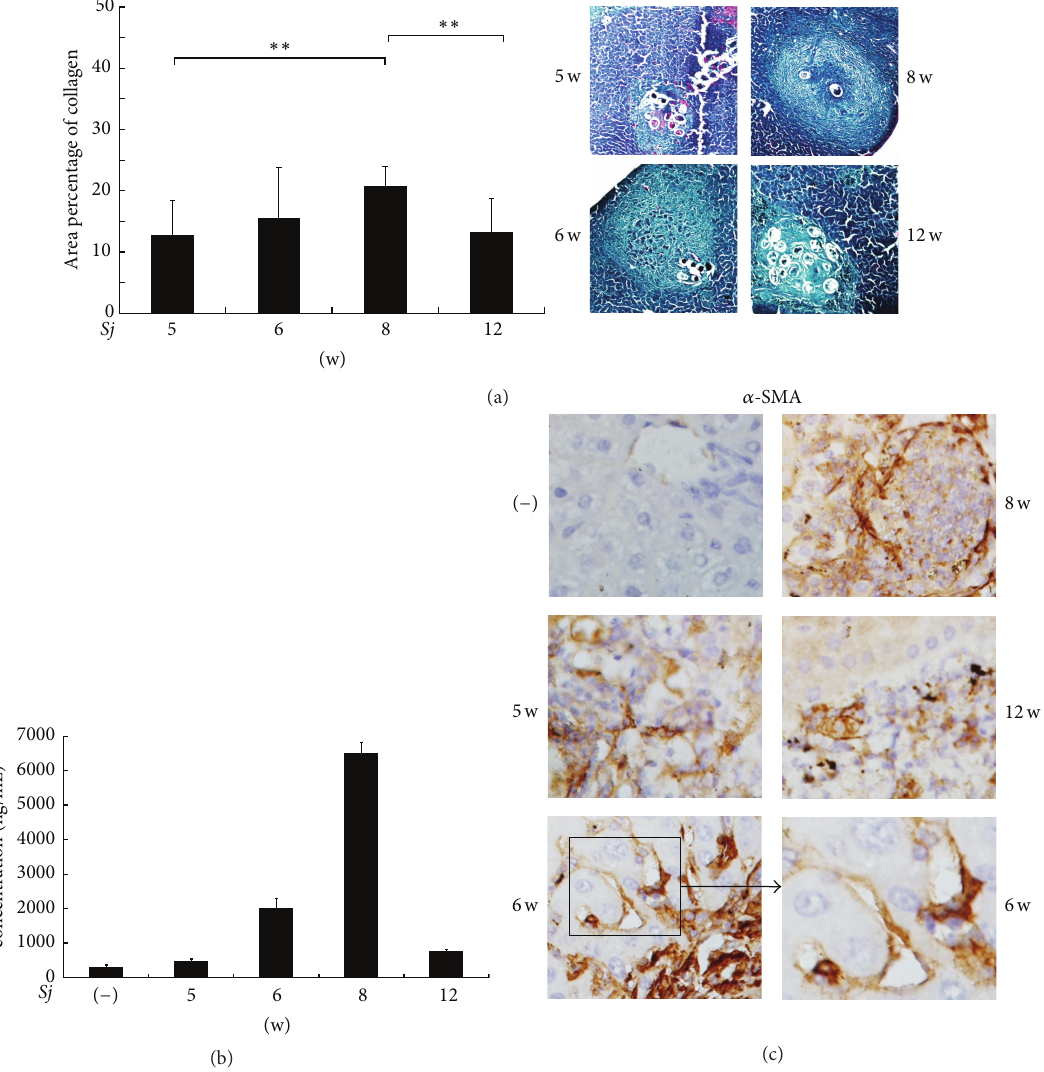
Figure 1: Extent of mouse hepatic fibrosis increased gradually after Sj infection. BALB/c mice were infected with 20 ± 3 infective cercariae of Sj for 5, 6, 8, and 12 weeks, and noninfected mice served as negative control. Liver tissues were fixed and stained with Masson trichrome or anti- 𝛼 -SMA antibody (original magnification 40x). Collagen deposition area percentage (Masson trichrome staining positive area percentage of each section) was calculated and shown in (a, left panel). Representative liver granulomas stained with Masson’s trichrome staining are shown in (a, right panel) at 20x magnification. Concentration of hyaluronic acid in mouse liver serum is shown in (b) through ELISA assay. Expression level of 𝛼 -SMA protein in mouse liver tissues is shown in (c) through IHC assay. Data are presented as mean ± SD from eight mice per group. Experiments were performed twice. ∗∗ 𝑃 < 0.01